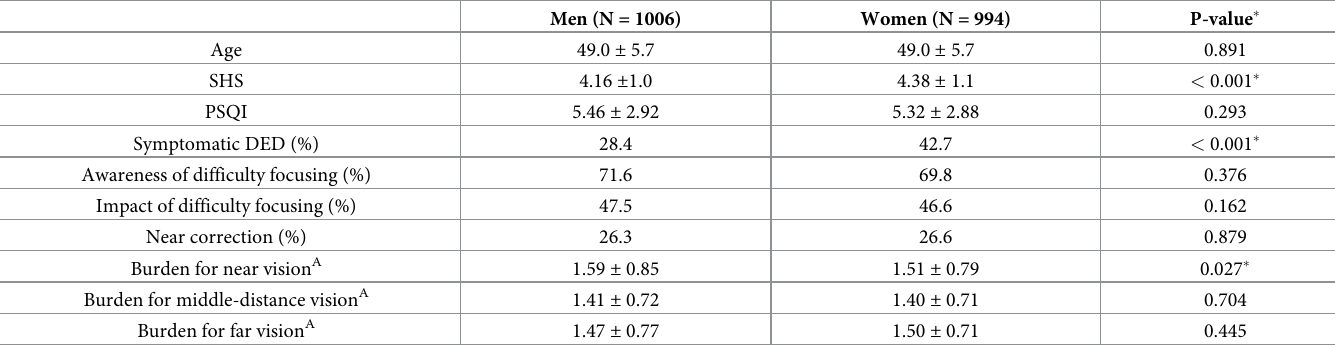
Table 1. Survey results of quality of life indices and ocular